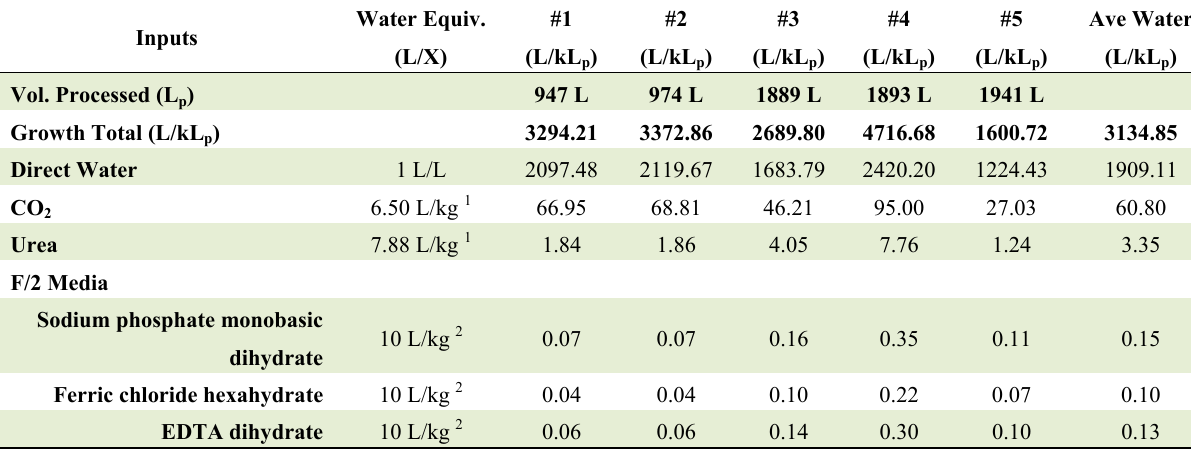
Table 3A. Water Consumption. Direct and indirect water consumption for 5 batches comprising the Experimental Case . Unless otherwise noted, data are reported in units of liters per thousand liters of processed volume (L/kL p